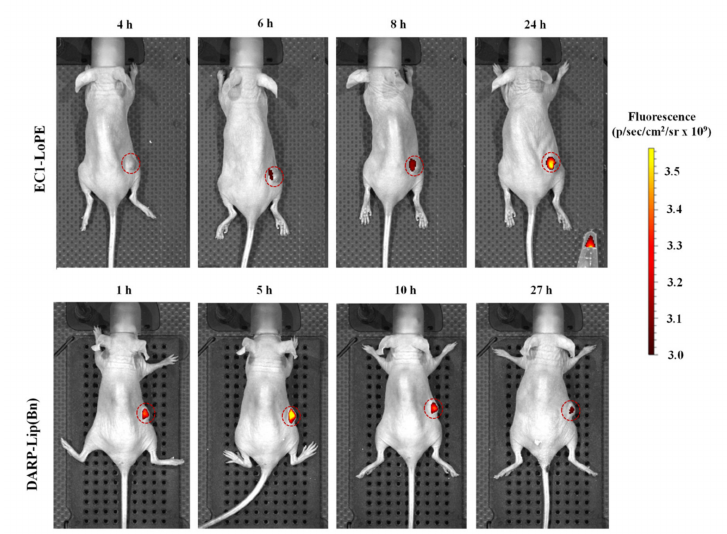
Figure 3. EpCAM / HER2-positive tumor imaging. Living animal photos confirming specific labeling of EpCAM (upper panel) or HER2 (lower panel)–overexpressing cells in vivo with EC1-LoPE or